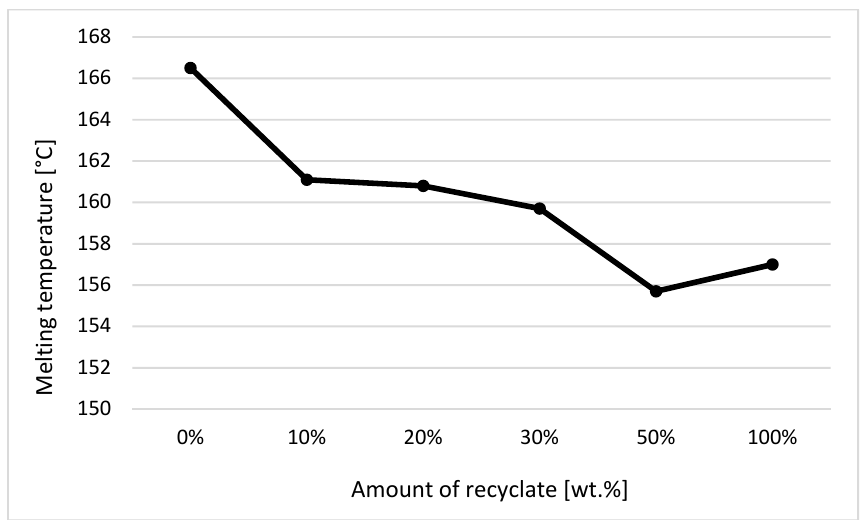
Figure 7. Dependence of the melting temperature on the proportion of weight of the recycled material after exposure of the samples to elevated temperature—component 2.